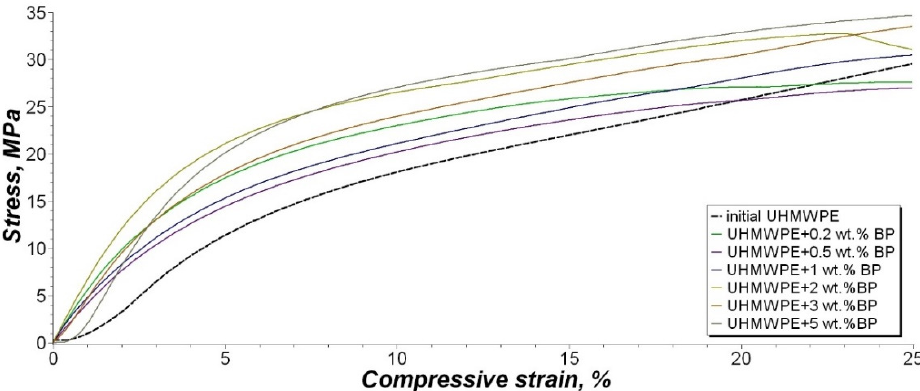
Figure 11. Stress–strain curve of the compressive tests.